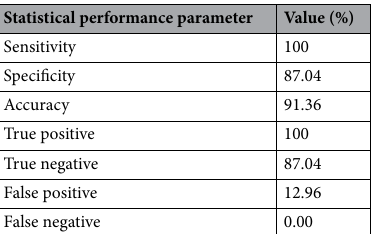
Table 2. Statistical parameters describing the efficiency of the breath